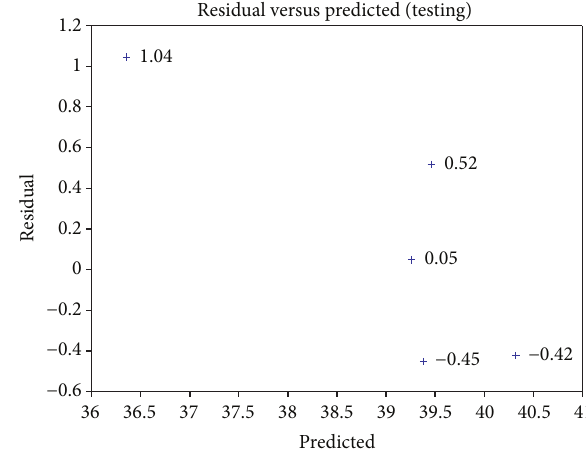
Figure 4: Comparison between residual values and predicted values during training process.